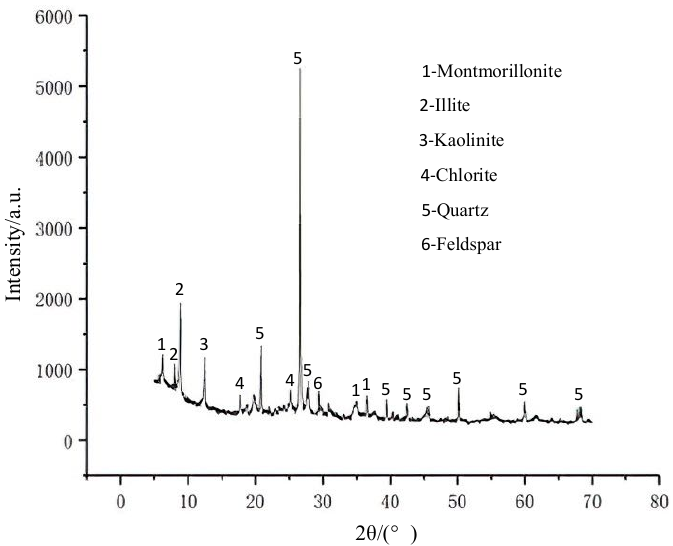
Figure 1. The grain-size distribution of clay.